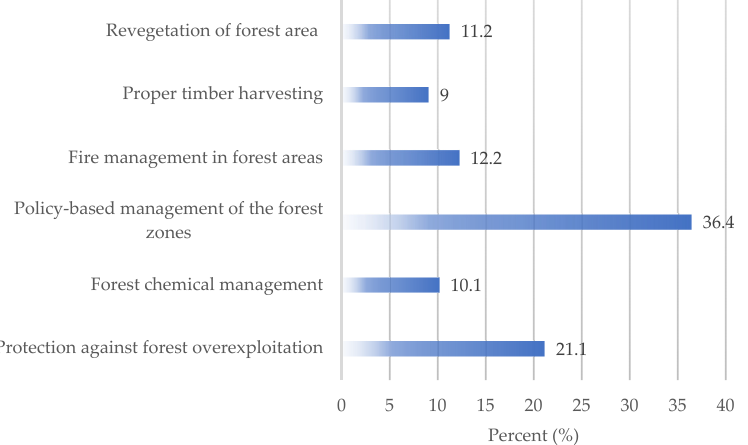
Figure 4. Key aspects in the management and exploitation of forests. Source: Authors’ own work (2022).